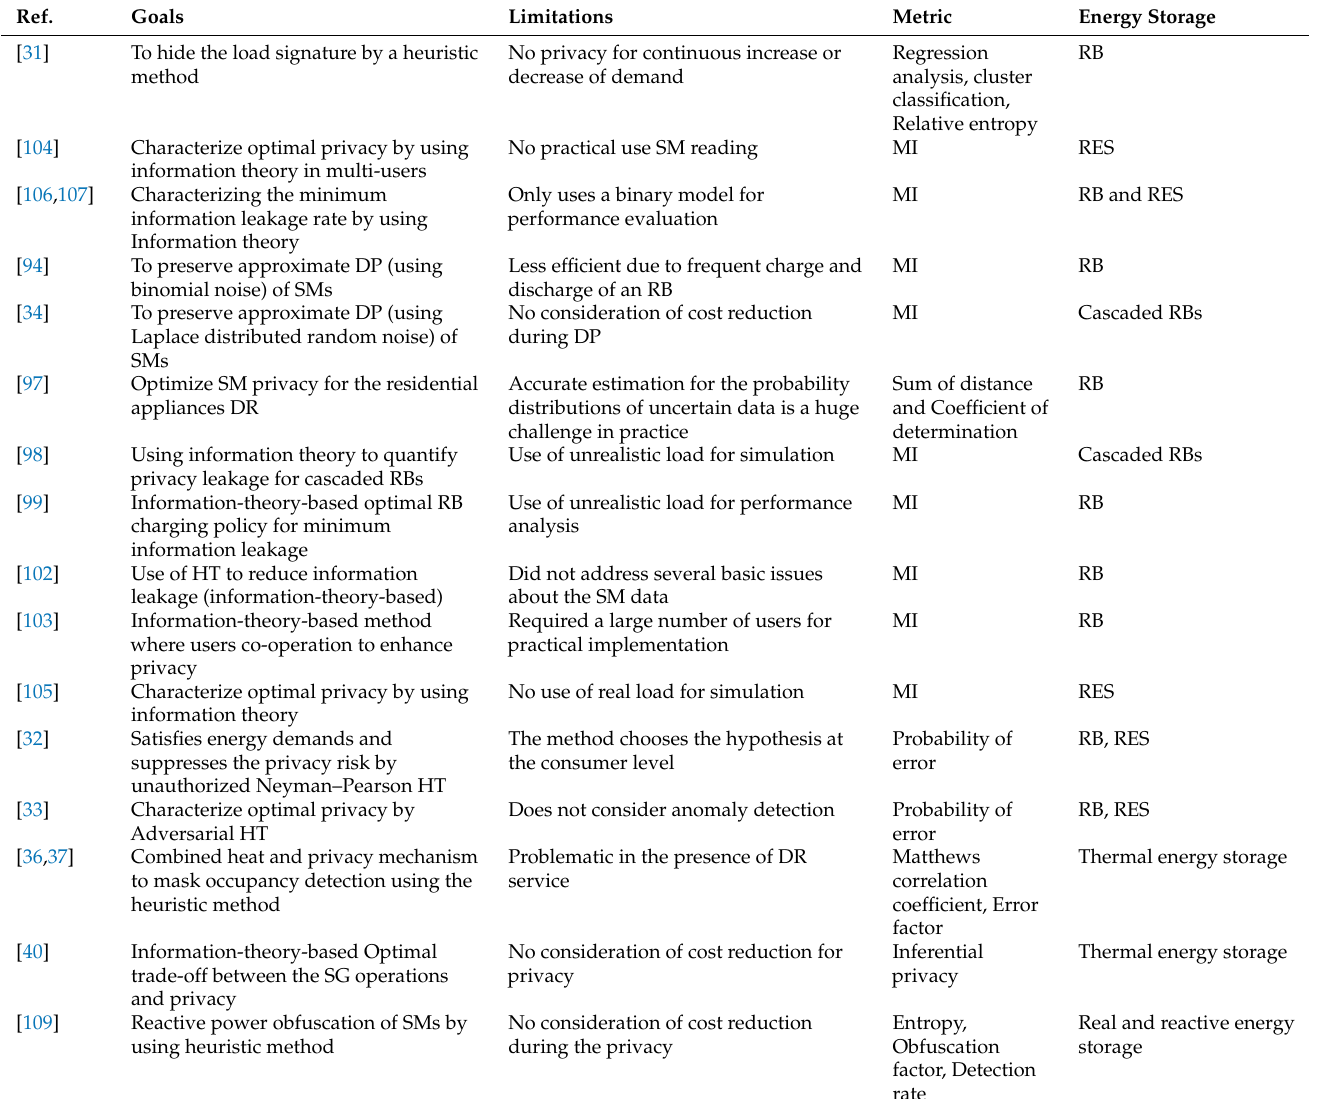
Table 6. Summary of SM privacy-preservation techniques against strong adversaries (prioritizing customer